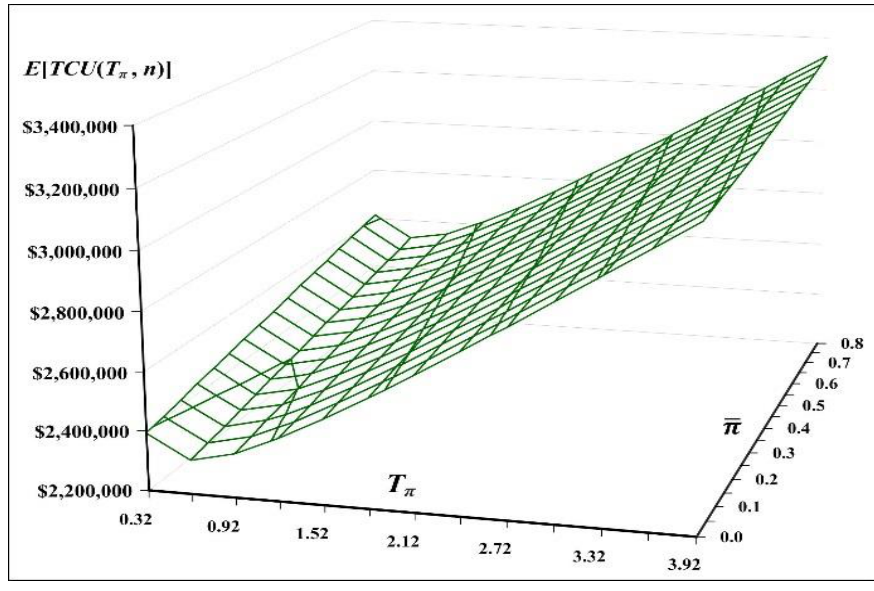
Figure 10. The joint impact of differences in T π and  on E[ TCU ( T π , n